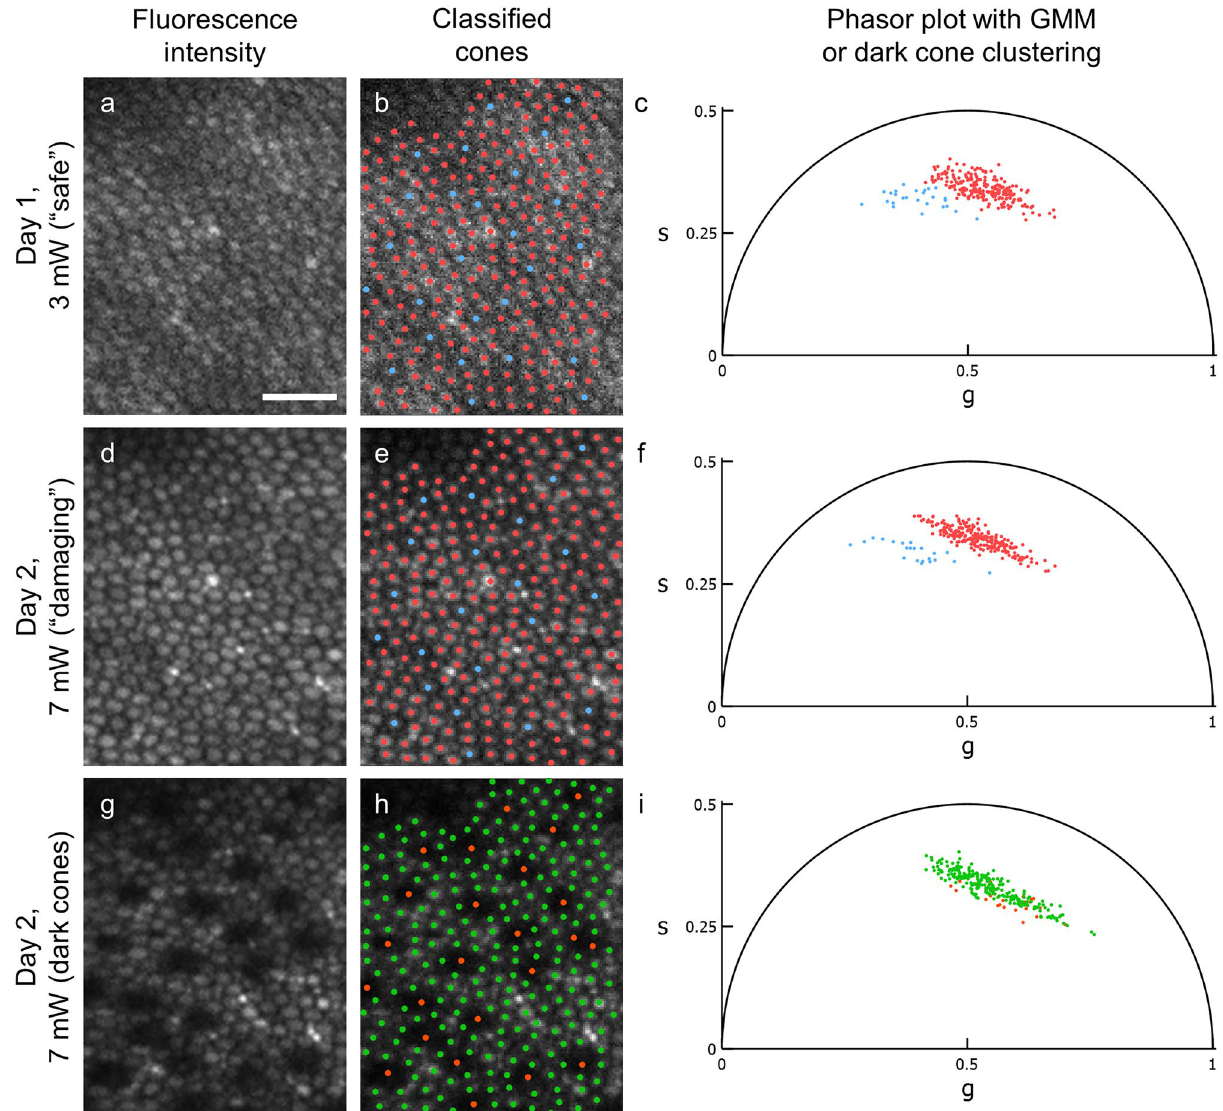
Figure 4. Tracking the phasor coordinates of cones before and after damage. Representative phasor data showing the correspondence between subsets of cones segregated by phasor analysis and those that eventually decrease in fluorescence intensity. An initial exposure (3 mW, 877 J/cm 2 , ( a–c )) was performed on one day and two consecutive high-level exposures (7 mW, 2047 J/cm 2 , ( d–i )) were performed on a subsequent day at the same location. In each fluorescence intensity image ( a,d ), the same 257 cones were marked ( b,e ) in red or blue according to their GMM cluster assignments in the corresponding phasor plots ( c,f ). 26 cones (10.1%) and 22 cones (8.7%) were assigned to Cluster 1 for ( b,e ), respectively. Each phasor coordinate represents one cone. The second Day 2 fluorescence intensity image ( g ) contains a semi-regularly spaced array of 24 cones whose intensity is noticeably lower than their neighbors. The corresponding image ( h ) and phasor plot ( i ) are marked according to whether (orange) or not (green) they decreased in fluorescence intensity. Cones obscured by the blood vessel shadow in the upper left corner of the image were not marked. Scale bar represents 20 second exposure of Paradigm 2 as non-dark cones. Finally, 1957 cones were classified as Cluster 2 in the initial exposure and as non-dark in the second exposure of Paradigm 2. Thus, phasor analysis on initial exposure cones predicts the cones that decrease in fluorescence intensity as observed in Paradigm 2 s exposure with a sensitivity of 89.1% and specificity of 98.6%. Overall, 86.3% of initial exposure Cluster 1 cones turned dark compared to 0.605% of initial exposure Cluster 2 cones. The average coordinates of Cluster 1 cones in the initial exposure and the second exposure of Paradigm 2 for the 10 locations are shown in Fig. 5; values are provided in Supplementary Table S1. The phasor coordinates of the second exposure of Paradigm 2 dark cones shifted rightwards relative to those initial exposure Cluster 1 cones. This indicates a shift towards shorter lifetimes. The means of the initial exposure Cluster 1 and Paradigm 2 dark cone cluster phasor coordinates are significantly different ( p < 0.0005). Plotting the individual g and s